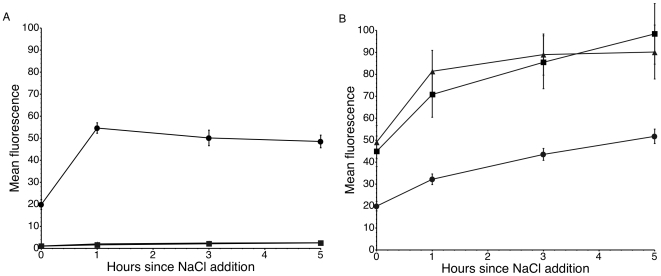
Expression of PotsBA measured by a gfp transcriptional fusion.Cells were transformed with a plasmid expressing gfp either from the wild-type PotsBA (A) or from PotsBA with IS10 inserted (B) into one of three genetic backgrounds: rpoS+ (circles), ΔrpoS (squares) or ΔrpoS−1 (triangles). Cells were grown over-night in MOPS MM, then diluted 1∶100 into fresh media and grown until they reached an OD600 of 0.25. At this point (time 0) a sample was taken, and NaCl was added to a final concentration of 0.3 M. Fluorescence was measured on a flow cytometer. The experiment was repeated three times, and error bars represent the standard error of the mean.